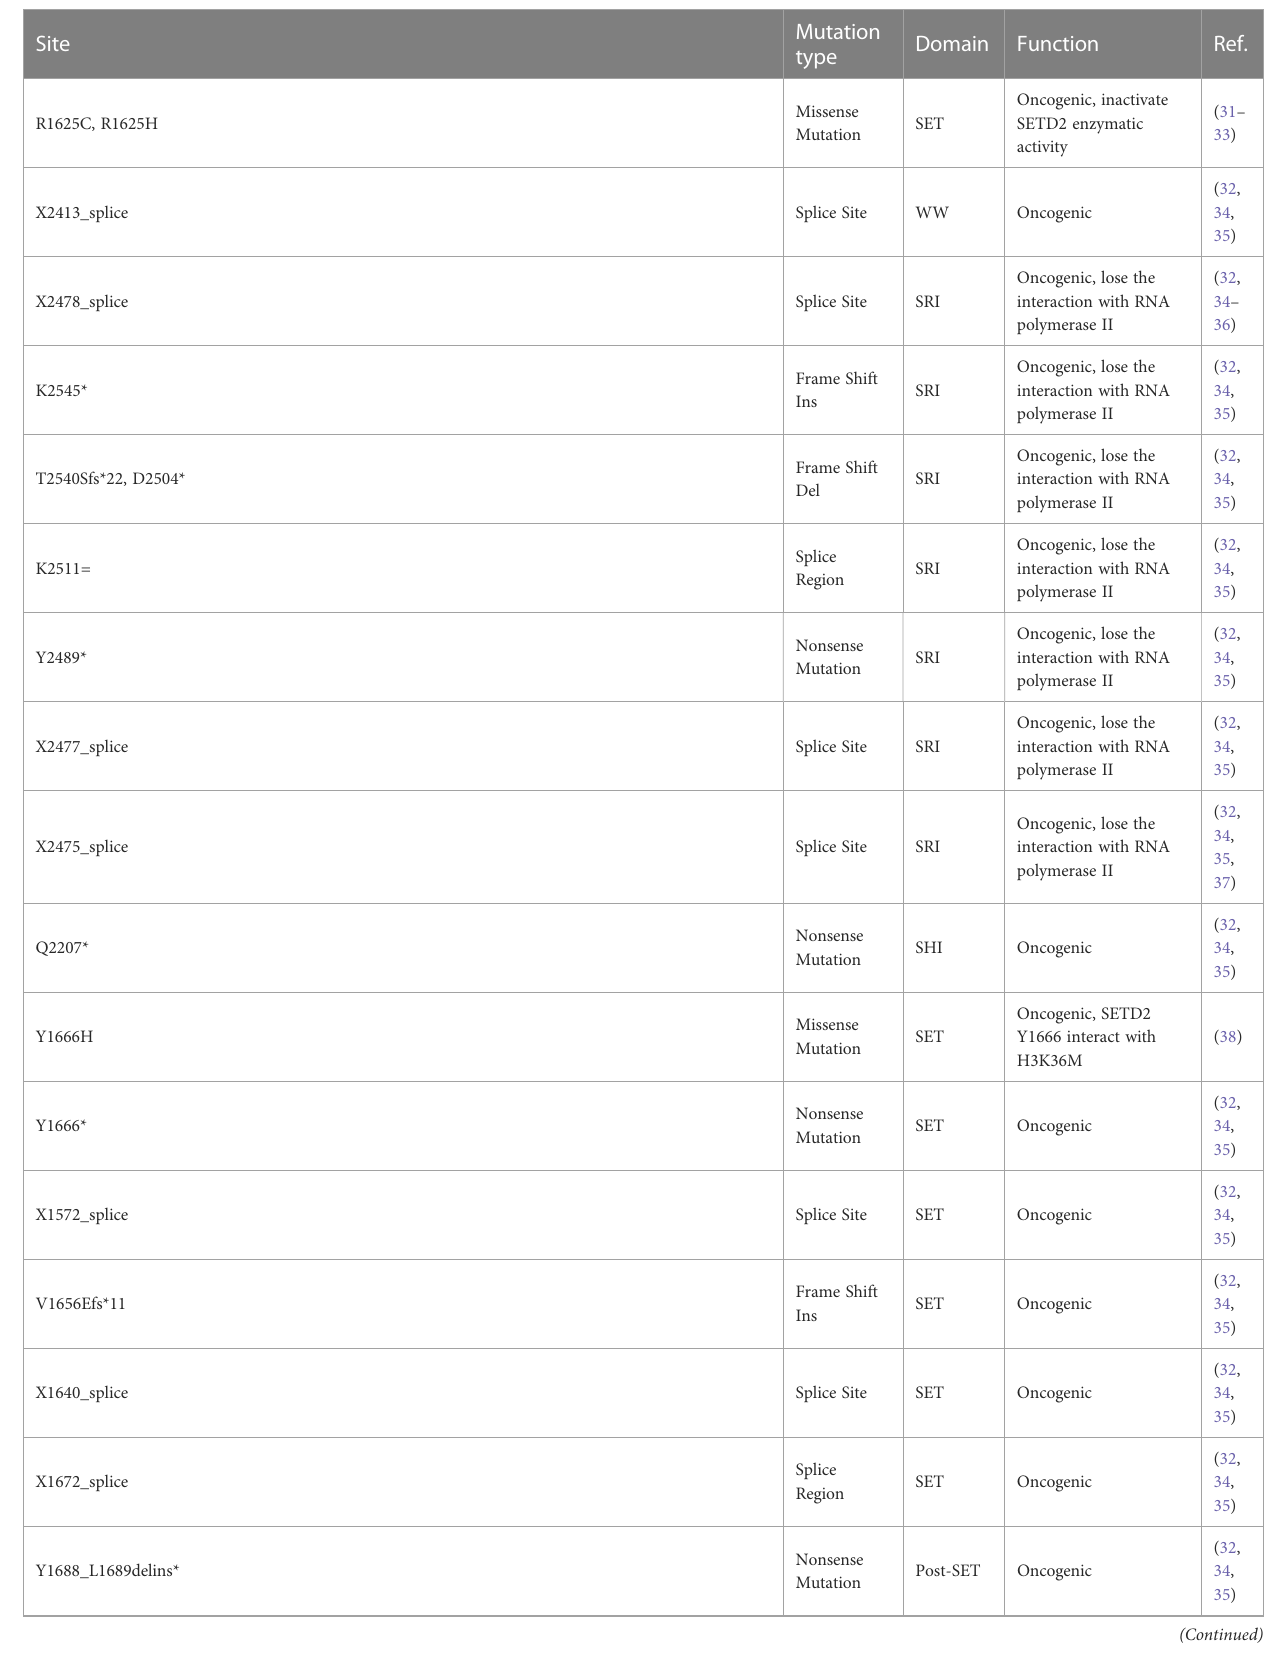
TABLE 1 List of SETD2 mutations reported in